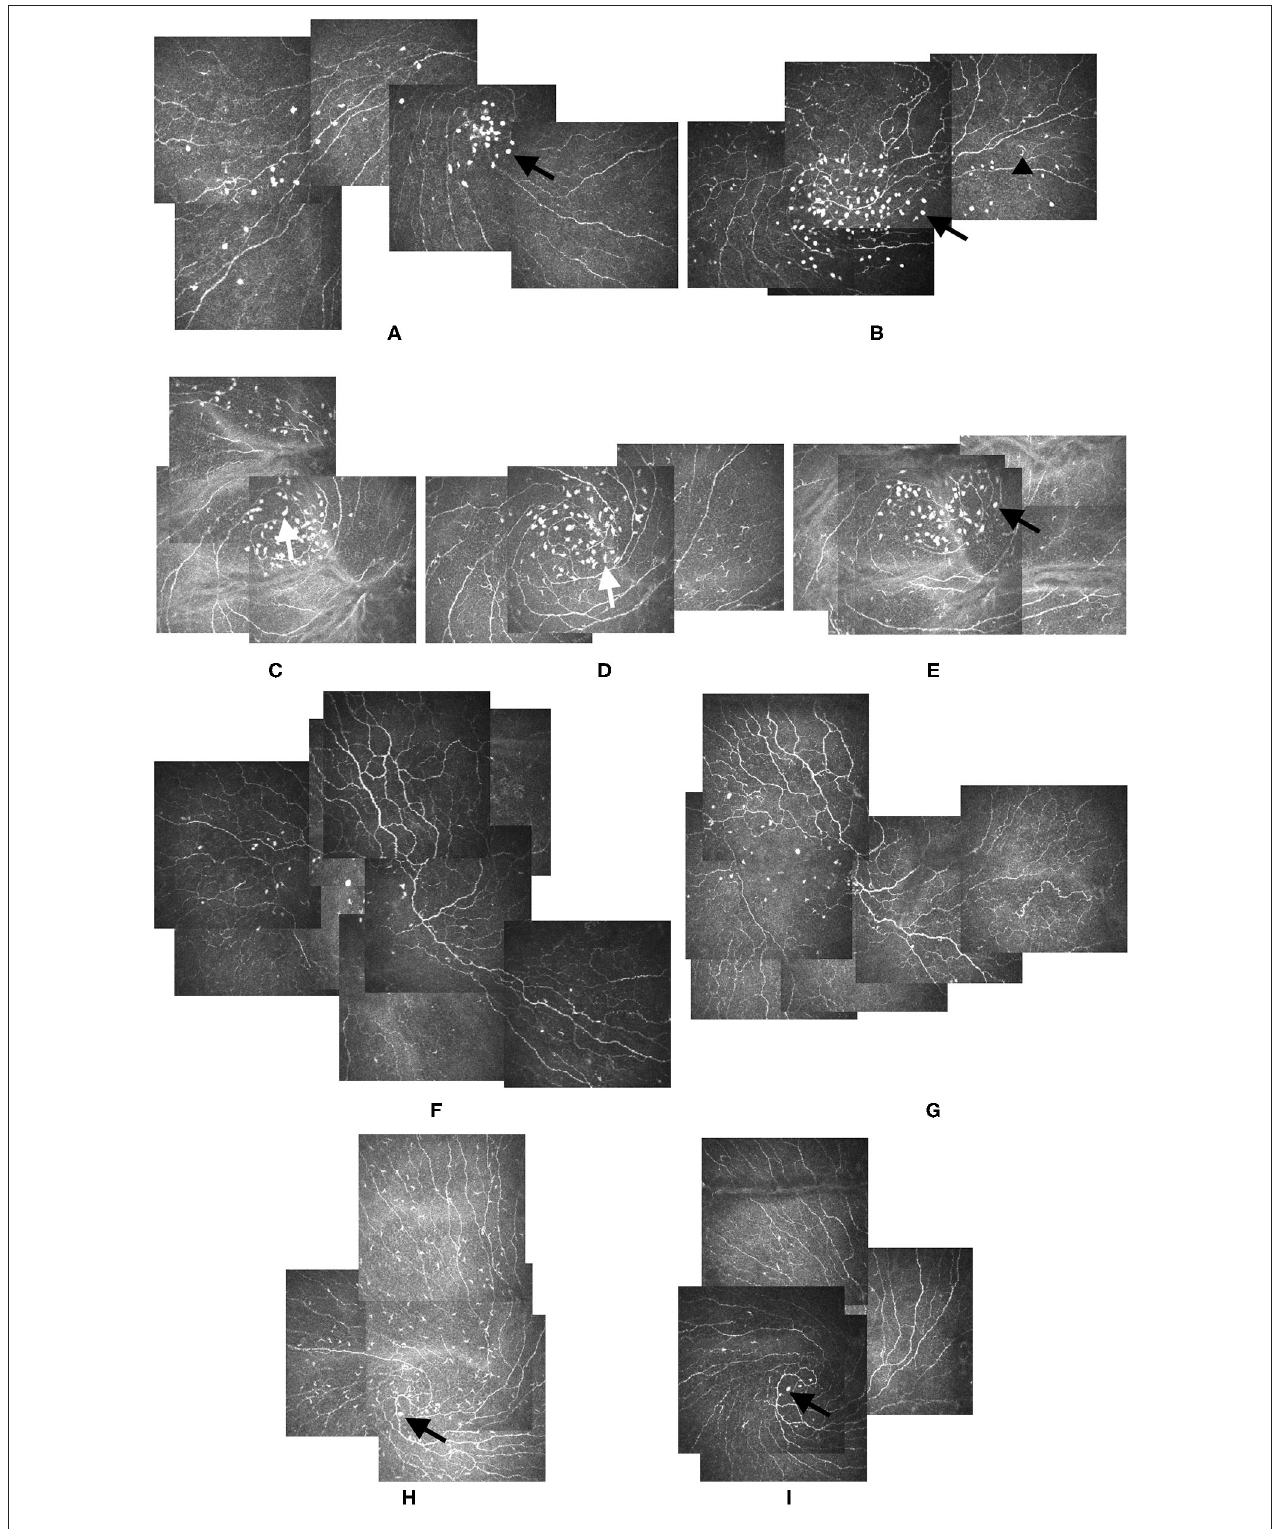
FIGURE 1 | Alterations of LCs and Globular cells during follow-ups. (A,B) Bright oval globular cells (black arrow) could be seen in the IVCM images from study participants: 37-year-old male (A) and 69-year-old female (B) . Though of varied sizes, the globular cells were larger than the LCs (black arrowhead), and